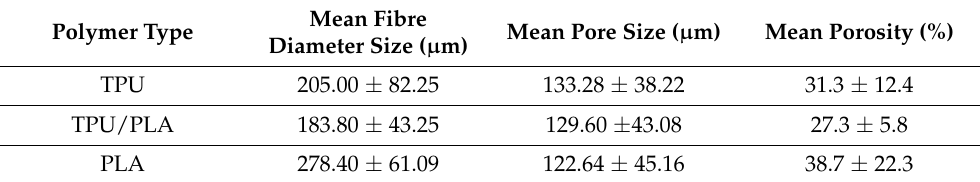
Figure 1. ( a ) Photographic images of the constructed disc-shaped scaffold. Images of TPU, TPU/PLA, and PLA scaffolds from the top view. Scale bar: 1 cm. ( b ) SEM images of the disc-shaped scaffolds from the surface and cross-sectional views of all scaffolds. Scale bar: 1 mm. Table 1. Mean fibre diameter, pore size, and porosity of the scaffolds.